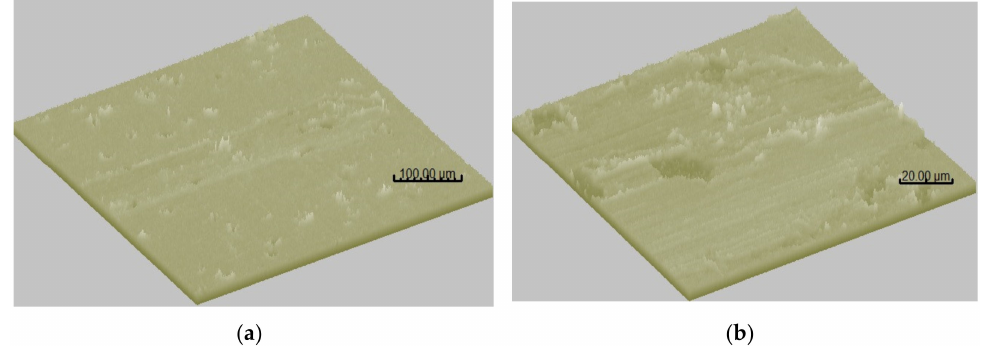
Figure 12. Scratch test—3D—probe exit area: ( a ) general view; ( b ) detail highlighting graphite nodules.